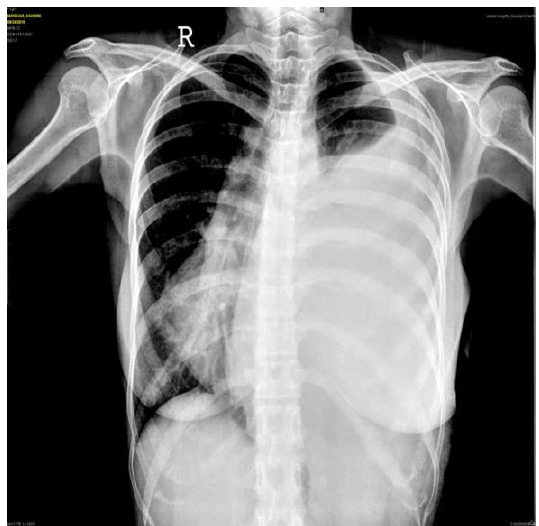
Figure 1. Chest x ray PA view on admission showing homogenous opacity in left hemithorax with shift of medistinum to right